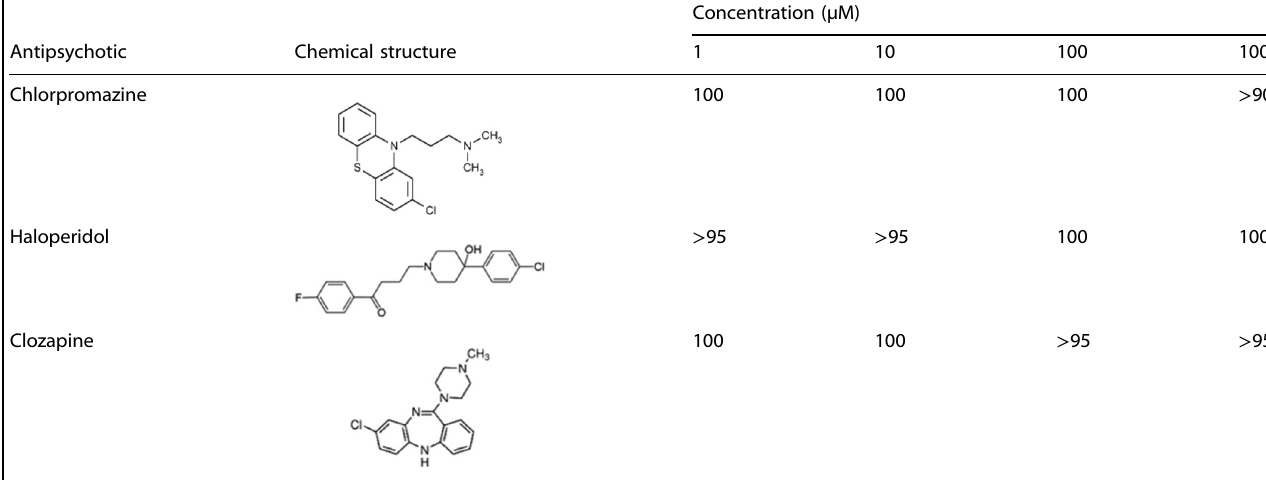
Table 1. Inhibition assays showing the relative activity (%) of recombinant human DDO (hDDO) in the presence of different concentrations of antipsychotic drugs